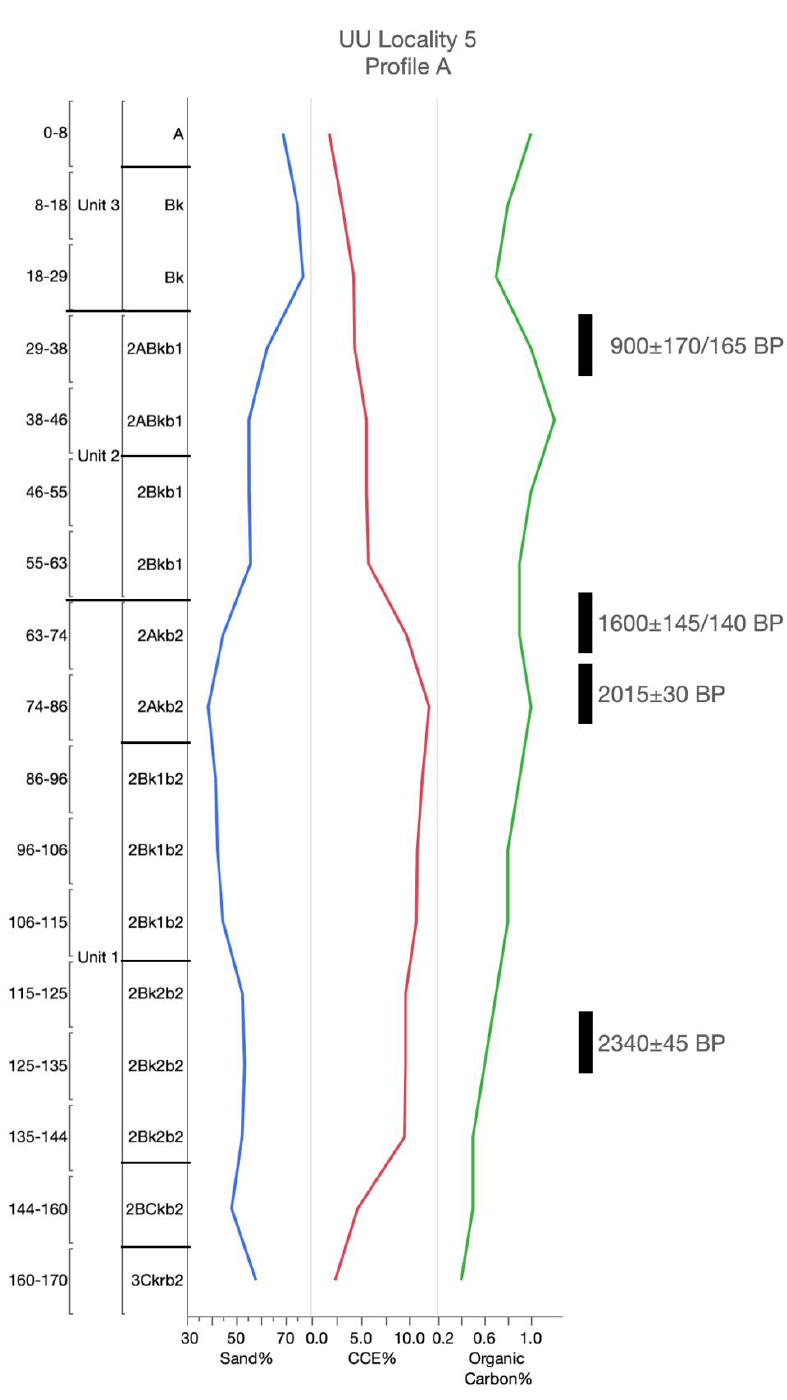
Figure A16. Accepted radiocarbon ages and soil and sediment analysis at UU Locality 5, Profile A—Post research area, northwest, Texas. CCE = calcium carbonate equivalence.